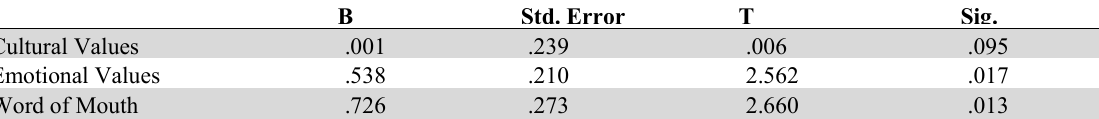
Regression analysis (Females) B Std. Error T Sig. Cultural Values .001 .239 .006 .095 Emotional Values .538 .210 2.562 .017 Word of Mouth .726 .273 2.660 .013 Dependent Variable: Buying Decision Satisfaction Regression analysis (Males) B Std. Error T Sig. Cultural Values .218 .136 1.604 .017 Emotional Values -.008 .231 -.035 .072 Word of Mouth .149 .234 .636 .029 Dependent Variable: Buying Decision